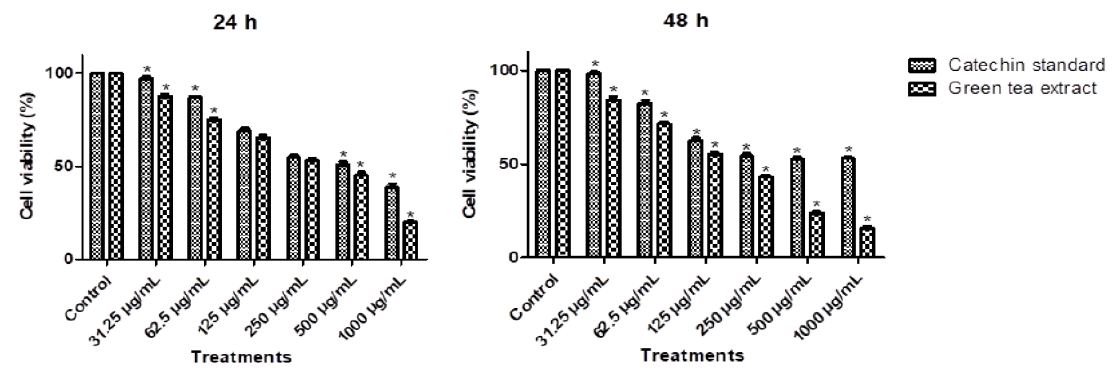
Figure 4. The viability of Huh7 cancer cells treated with standard catechin and green tea extracts at concentrations of 31.25, 62.5, 125, 250, 500, and 1000 µg/mL compared to untreated control. Cells were treated with the indicated concentrations for 24 h and 48 h using the MTT assay * ( p < 0.05).